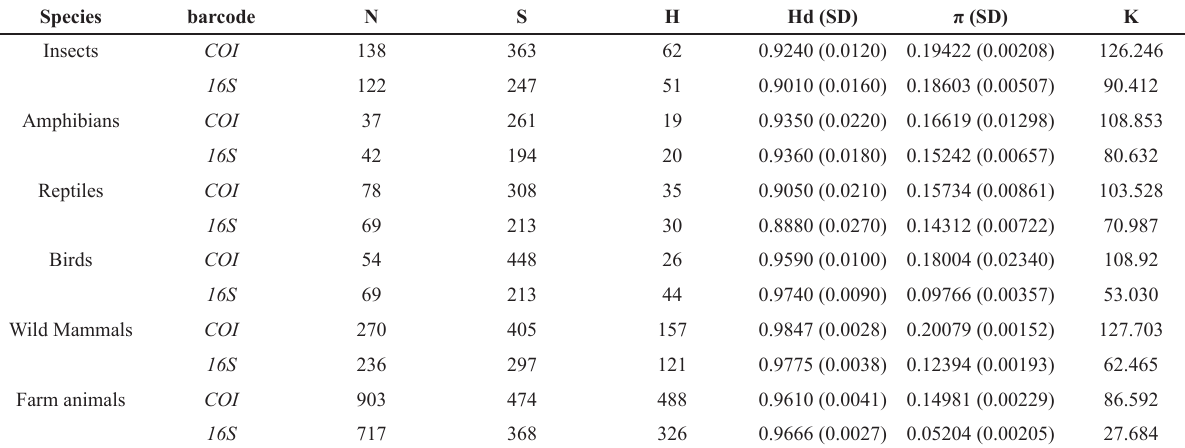
N=number of sequences; S=number of polymorphic sites; H=number of haplotypes; Hd (SD)=haplotype diversity (standard deviation); π